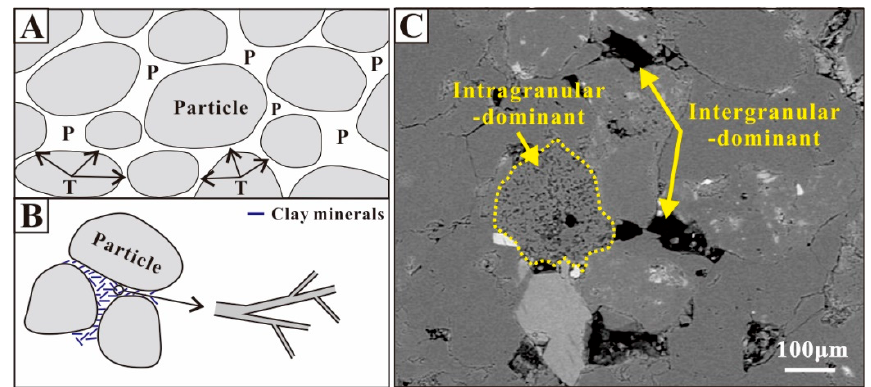
Figure 11. Schematic diagrams showing ( A ) conventional pore-throat structures that larger pores are connected by wider throats, and ( B ) tree-like pore structures that the narrower throats are connected to the wider throats like tree branches. ( C ) SEM image of sample #4 exhibiting an intergranular-dominant and intragranular-dominant pore network. P-pore; T-throat.